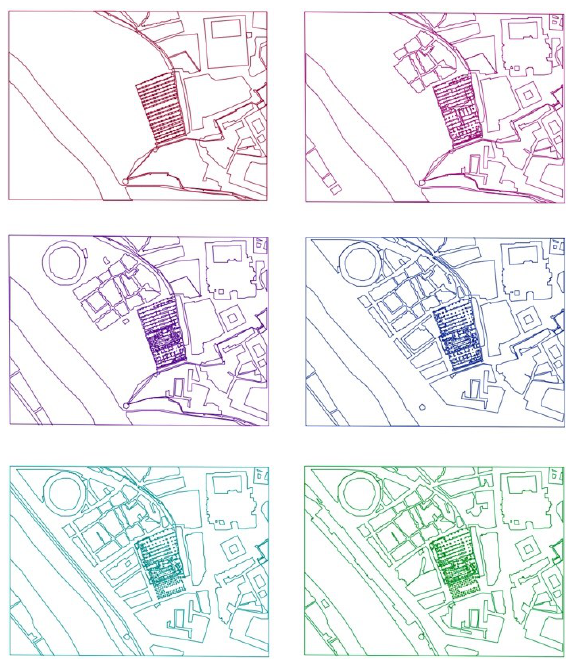
Figure 7. Screenshot of the 2D drawings made for the historical evolution of the shipyards and its surrounding: 13 th , 16 th , 17 th - 18 th , 19 th and 20 th centuries. (The authors,